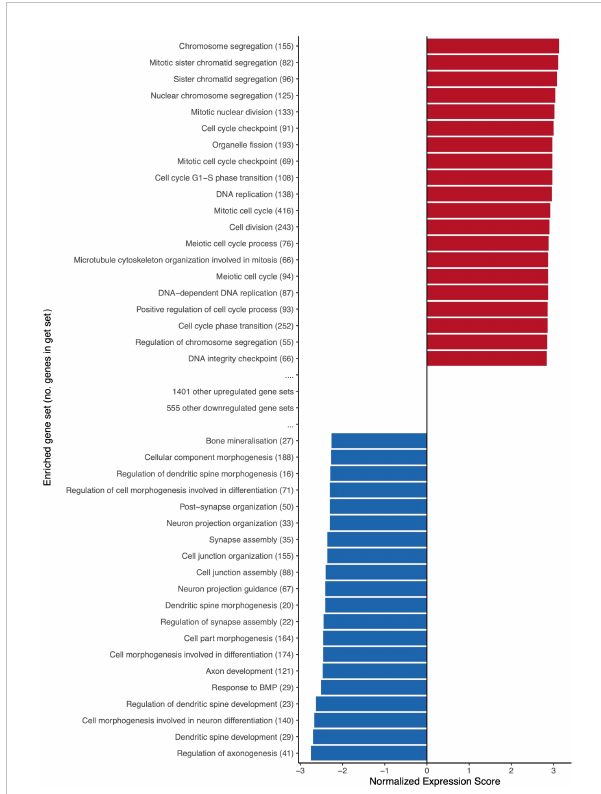
FIGURE 7 The top 20 most upregulated and downregulated biological process gene sets during acute HIV. Upregulated gene sets overlap to promote functions relating to cell cycle, DNA repair and replication, and immune response. Normalized expression score re fl ects the degree to which a gene set is overrepresented at the top or bottom of a ranked list of genes, adjusted for differences in gene set size and in correlations between gene sets and the expression dataset. Brackets following gene set names indicate the size of (i.e. number of genes within) an enriched gene set. Only signi fi cantly enriched gene sets (p<0.05) are